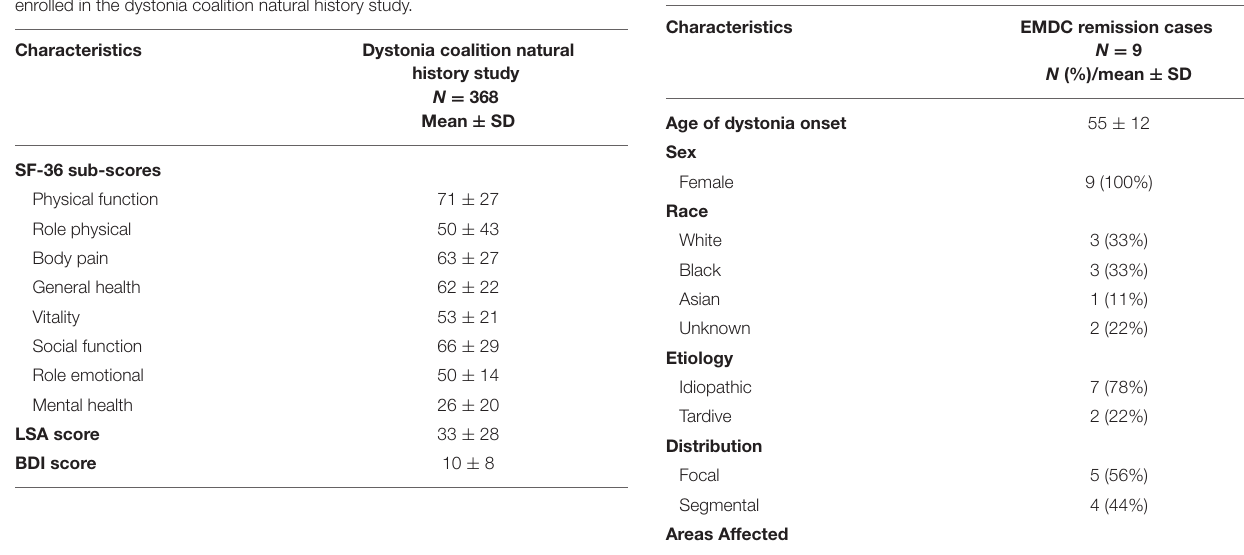
TABLE 4 | Characteristics of remission in oromandibular dystonia